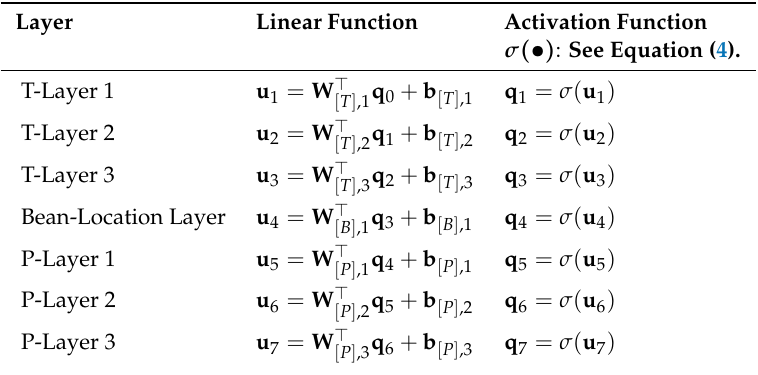
Table 3. Sketch of linear and activation functions for the BSDN in this work. The input q 0